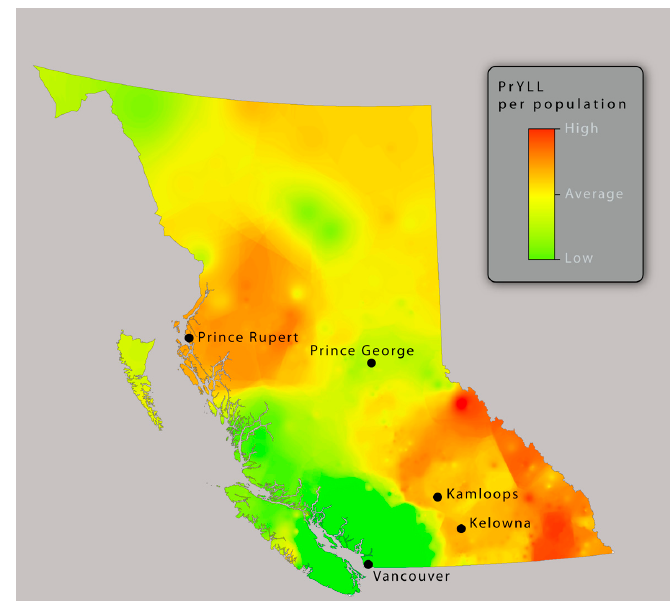
Figure 2. Spatial clustering of PrYLL per capita. Clusters of high PrYLL are shown in red, and tend to occur in rural and remote